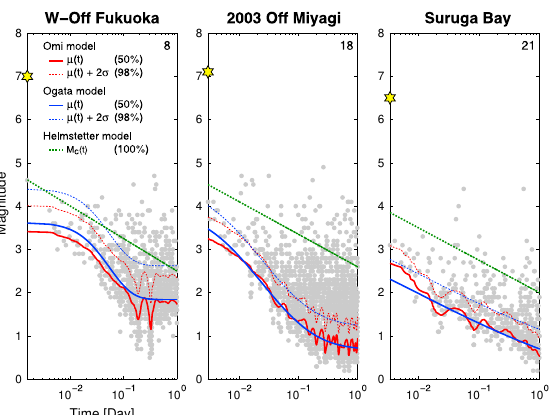
Figure 3. Examples of the estimated time-varying 50% detection rate µ ( t ) (solid curve) of magnitudes and estimated various time-varying completeness magnitudes (dotted curve) as indicated in the inset, superimposed on the magnitude-time plot of the observed aftershocks during the first day of the main shock. From